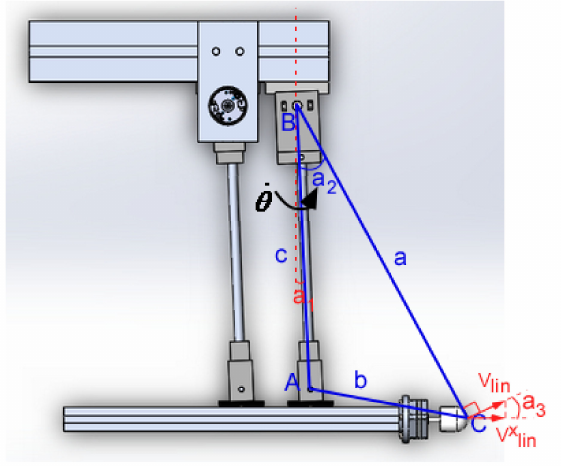
Figure A6. Schematic representation of impactor tip angle, where v lin is linear velocity; v x lin is its x-component; p is the angle between x-axis and linear velocity vector; a is the distance between the tip of the impactor and point B, measured before testing and a1, a2 and a3 are rotation